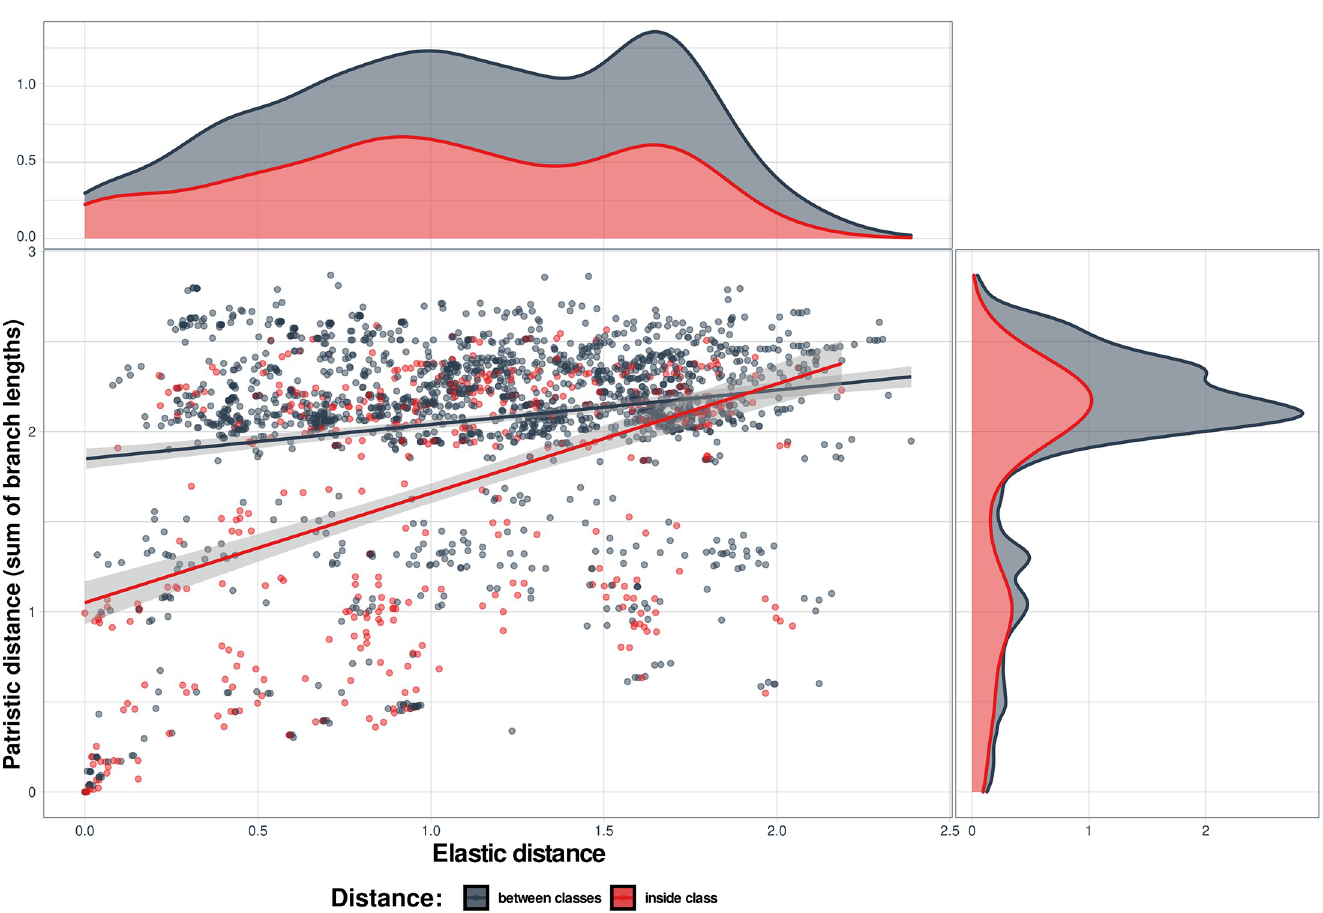
Fig 9. Comparison of elastic and patristic 1 distances between coronavirus genomes. The DNA sequences were grouped according to disease they cause. Genome pairs where the both genomes belong to the same group are highlighted in pink, the inter-group pairs—in gray. Shadows along the regression lines depict 95% confidence limits. The distribution of the values of elastic distances is presented above the main graph and patristic distances on its right side. Within group τ = 0.261, p = 2.2e-16; between groups τ = 0.068, p = 1.47e-05.